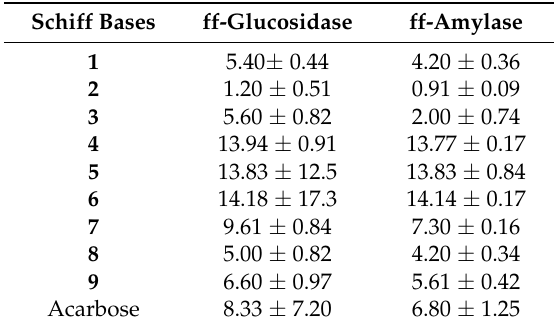
Table 6. α -glucosidase and α -amylase inhibition activity of Schiff bases 1 – 9 .